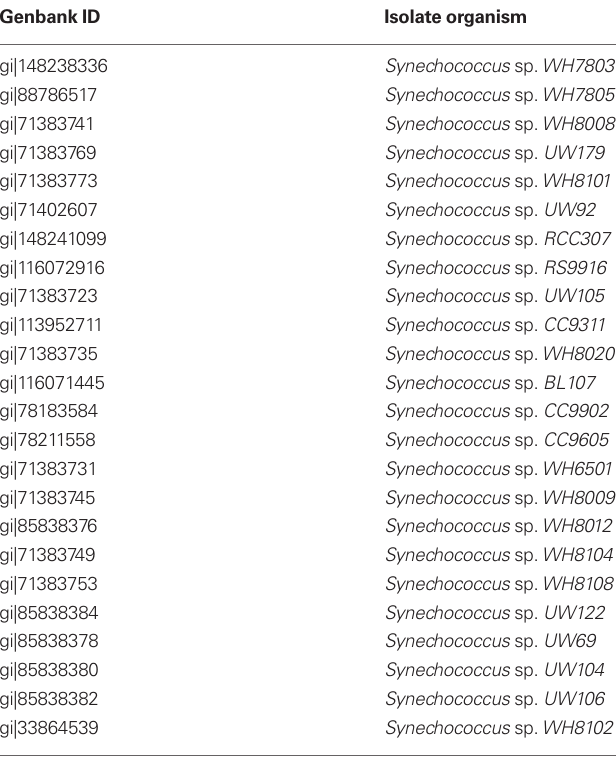
Table A2 | genBank iD’s for cyanobacterial isolates included on the generated narB phylogenetic tree (Figure